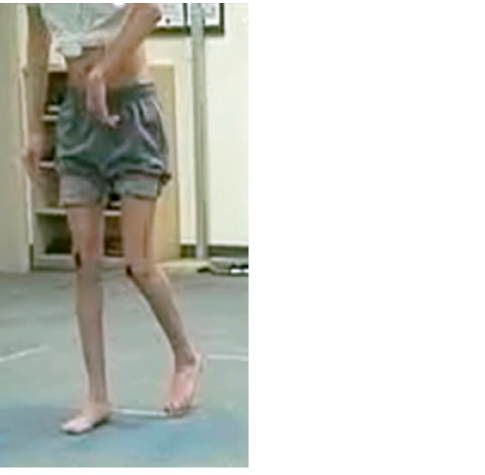
Figure 4. A hemiplegic patient with asymmetrical posturing of the upper extremity during